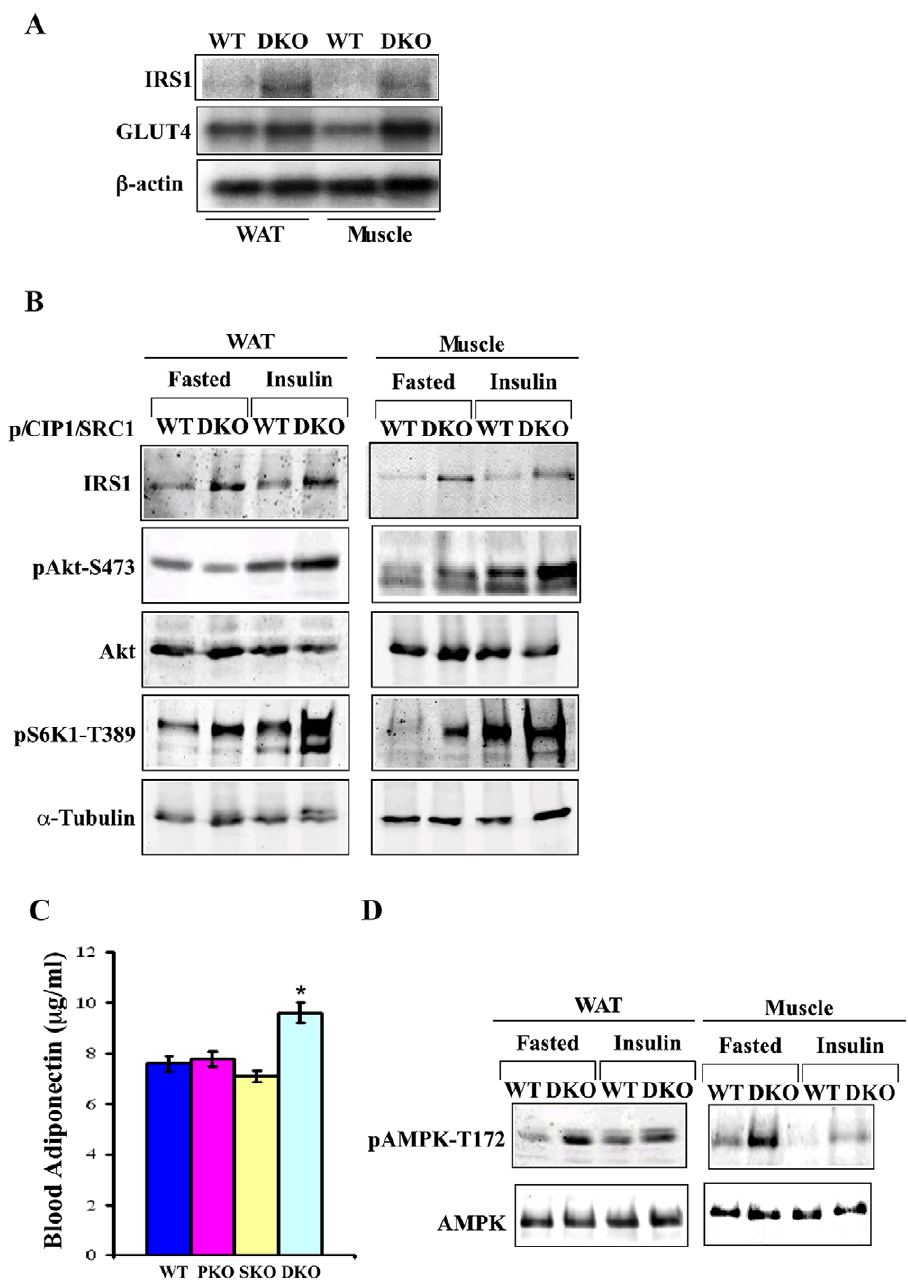
Figure 2. The DKO mice have increased IRS1 levels and insulin signaling. Three-month old mice were fasted overnight, injected (ip) either with insulin or with saline (fasted control), and mice were euthanized for tissue harvest. Cell lysates or total RNAs were prepared from white fat and muscle. A. Total RNAs isolated from white fat and muscle of fasted mice was used for Northern blot analyses. B. Tissue lysates of white fat and muscle of fasted and insulin treated mice were subjected to immunoblot analyses. C. DKO mice exhibited higher blood adiponectin levels. * p , 0.05, ** p , 0.005, and *** p , 0.0005. D. Immunoblot analyses with AMPK and phospho-AMPK antibodies were performed.